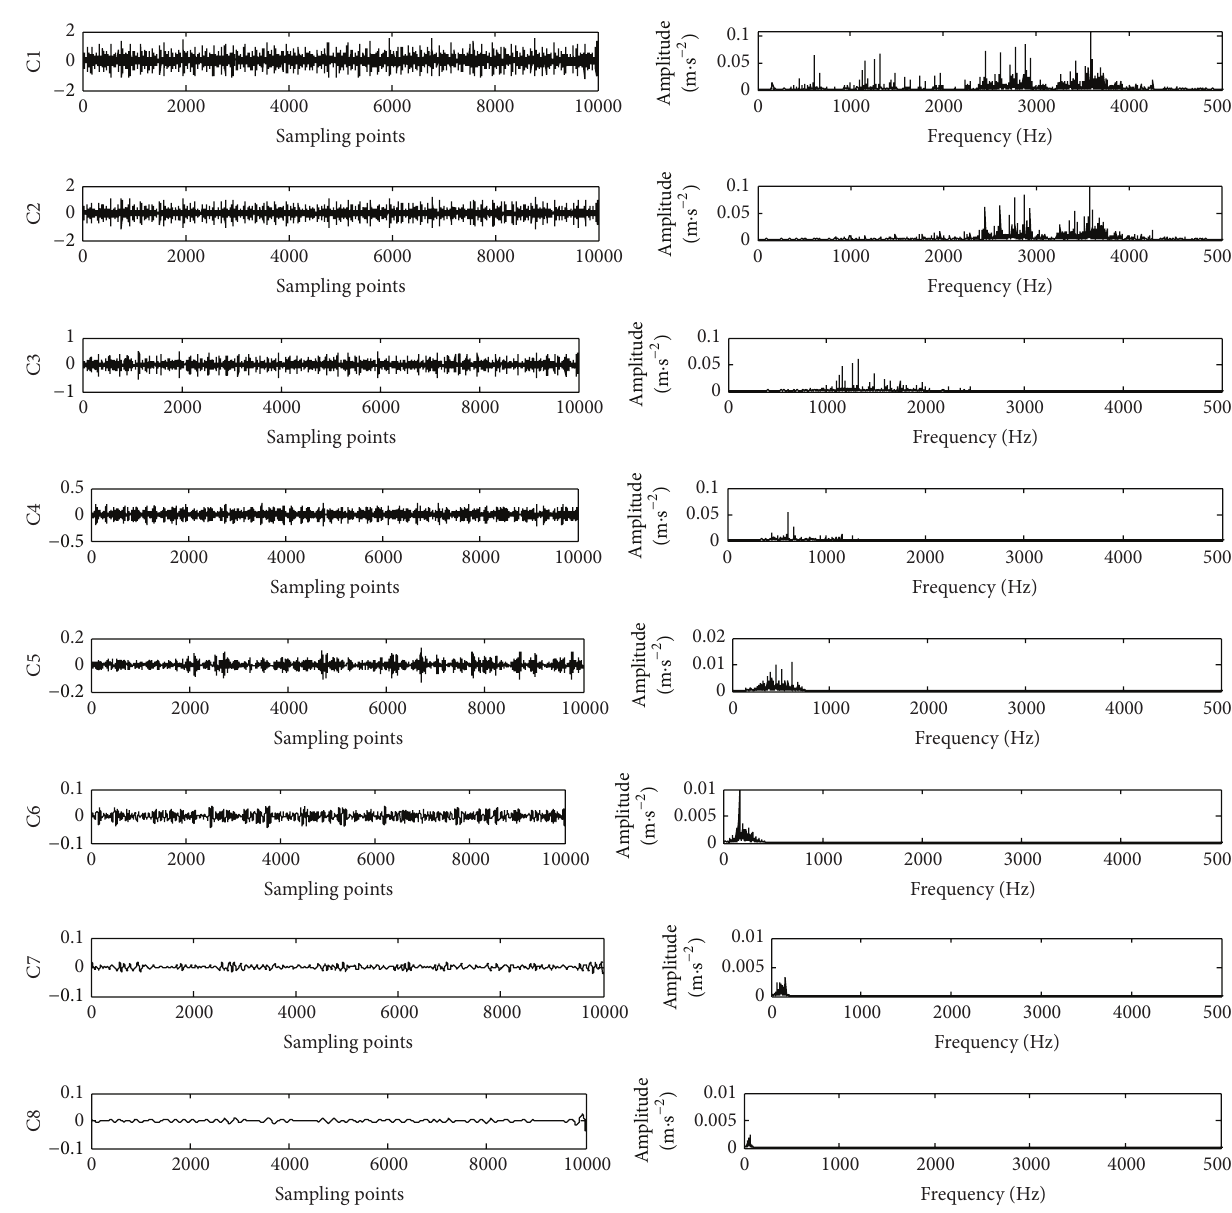
Figure 8: The EEMD components of original fault signal and its